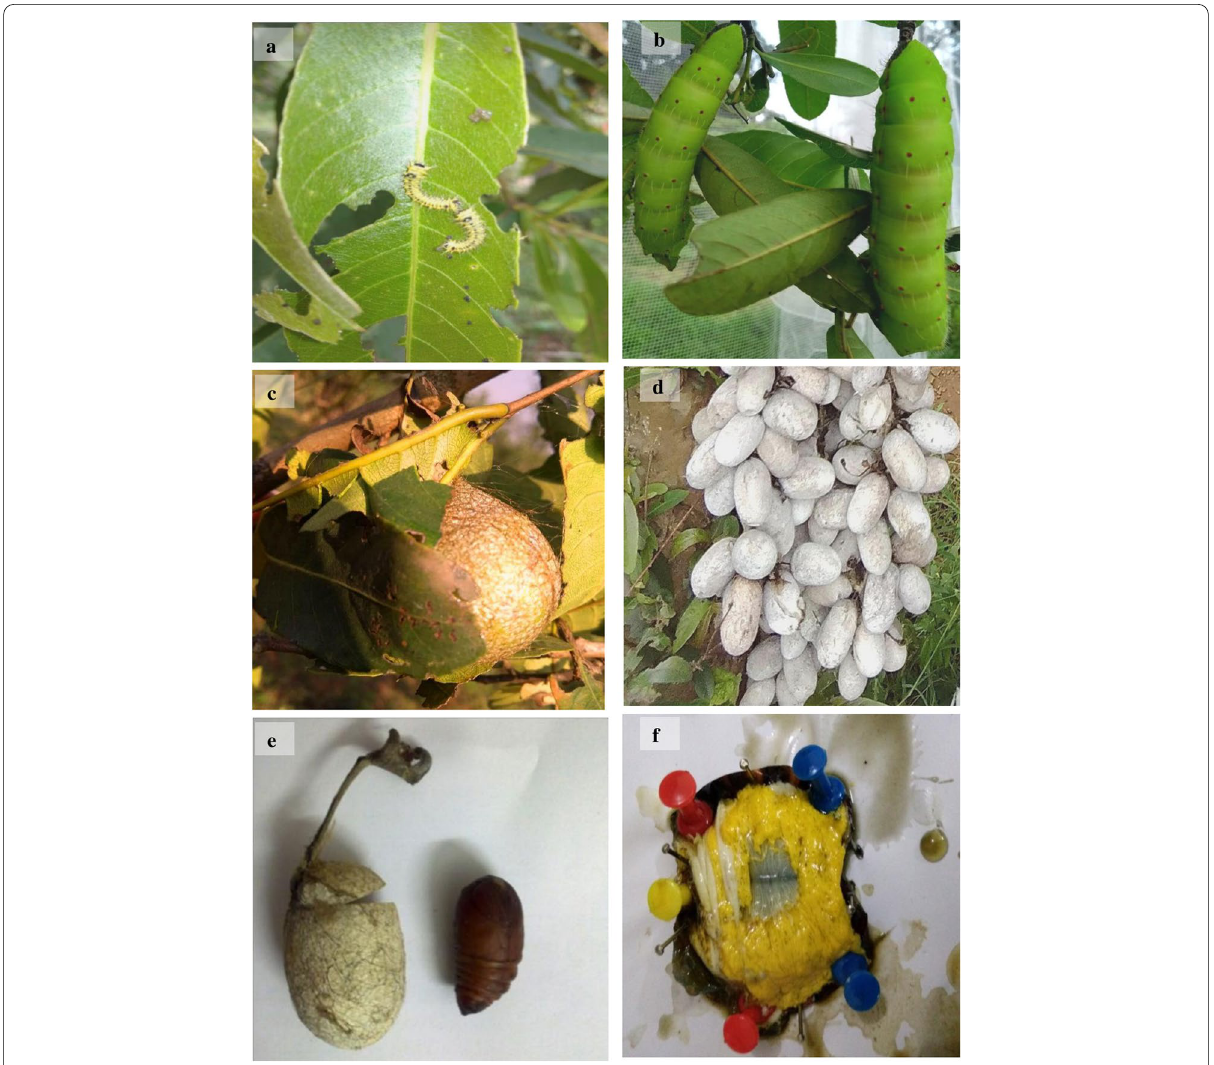
Fig. 2 Antheraea mylitta . a 2nd instar larva stage feeding on T. tomentosa , b 4th larvae stage in natural habitat, c and d Antheraea mylitta cocoons on the Terminalia tomentosa in natural environment, e 5th instar pupa sample, and f dissection of 5.th instar pupa sample for RNA